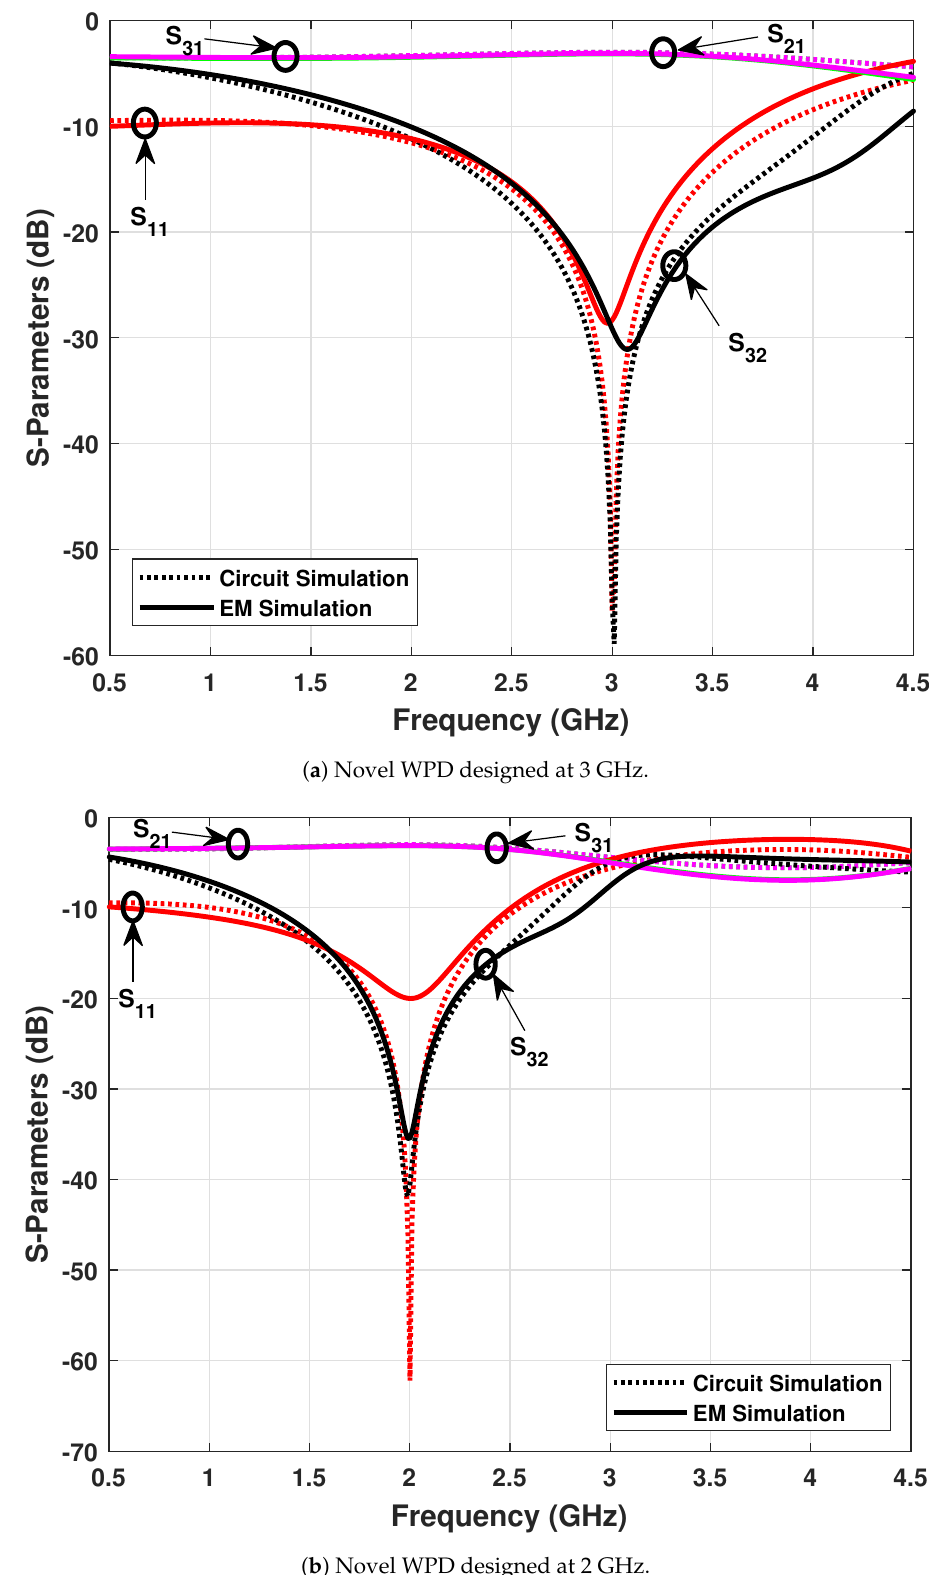
Figure 11. Simulation results of the proposed WPD